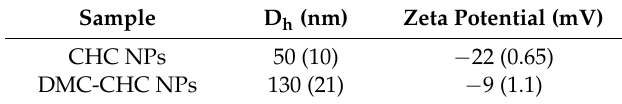
Table 1. Characterizations of DMC-CHC NPs. One standard deviation is given within parentheses ( n =